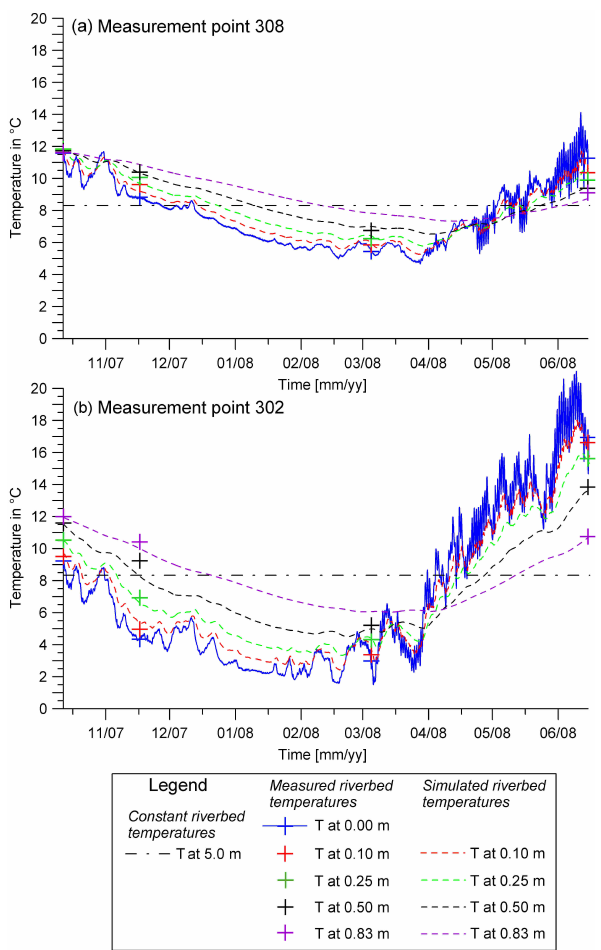
Fig. 5. Setup of the transient STRIVE model with results from measurement point 308 (a) and 302 (b) . The riverbed temperature at 0.0m depth serves as upper model boundary, a constant tem- perature at 5.0m depth (the dashed-dotted line) as lower bound- ary. The crosses indicate the measurements with the T-stick in- strument, whereas the dotted lines indicate the simulated tem- peratures at the respective points for the best model fit. (a) Soil type I, flux= − 6.5mmd − 1 , RMSE=0.41 ◦ C; (b) Soil type II, flux= − 26.2mmd − 1 , RMSE=0.46 ◦